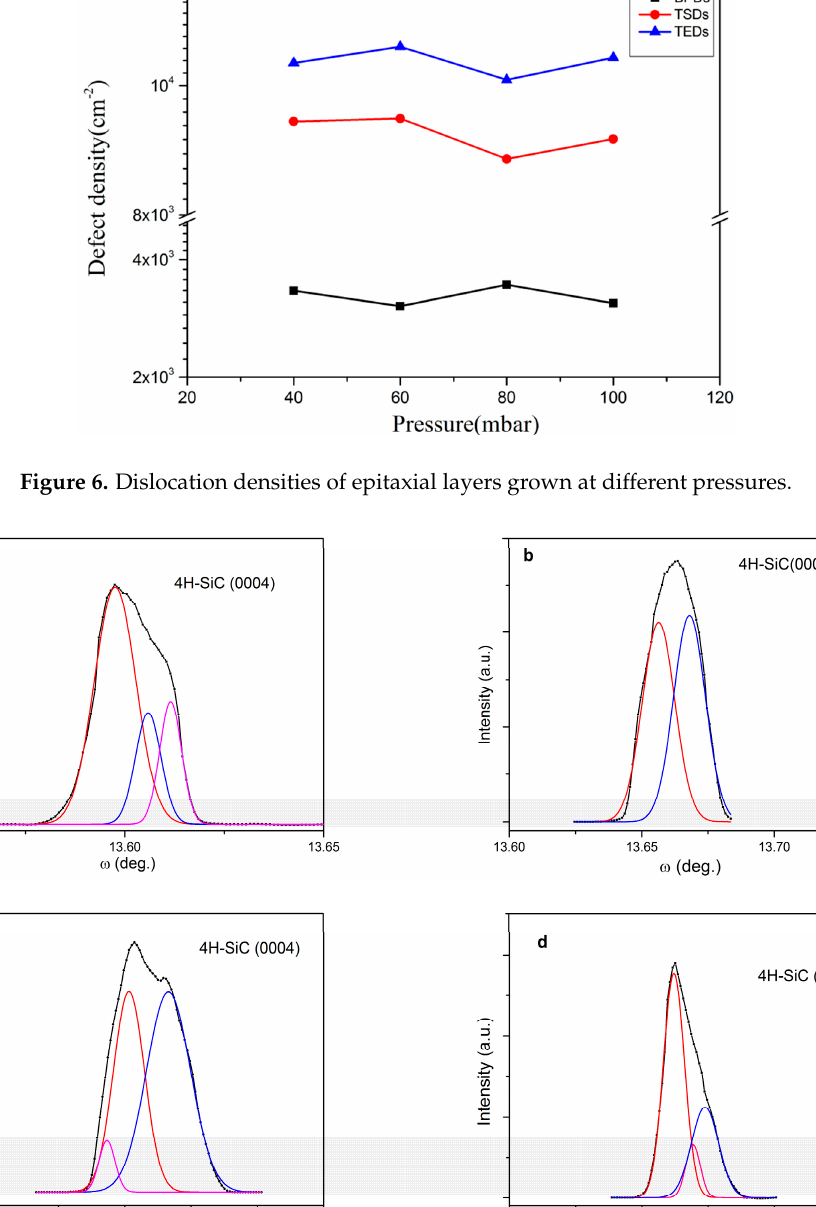
Materials 2016 , 9 , 743 7 of 10